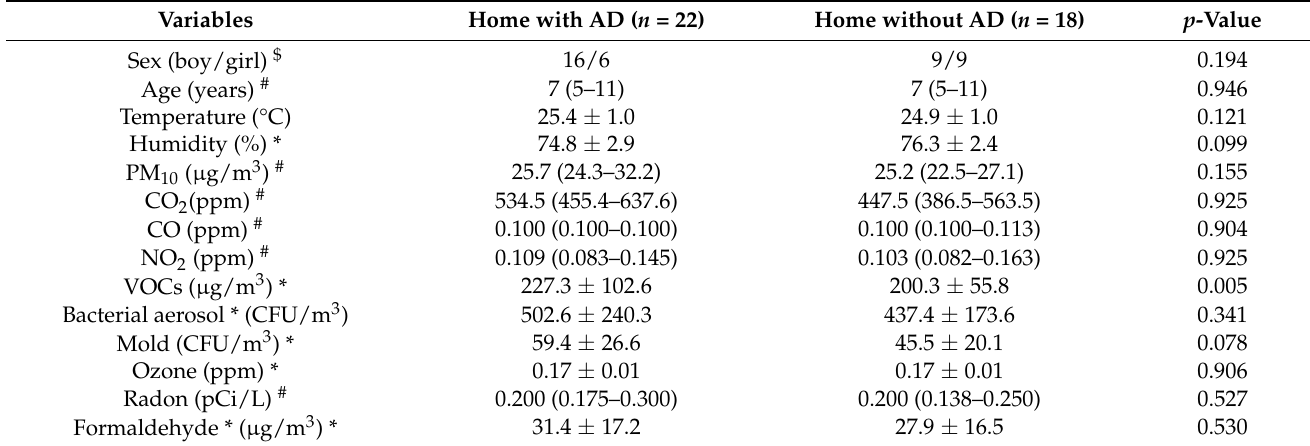
Table 1. Demographic data of study